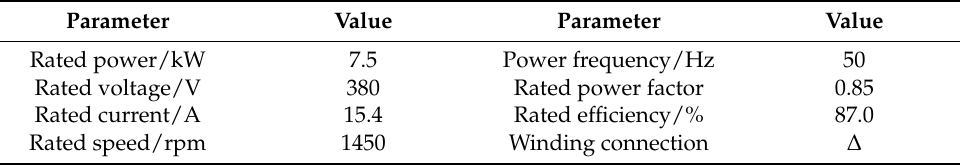
Table 2. Nameplate parameters of the experimental squirrel-cage IM.